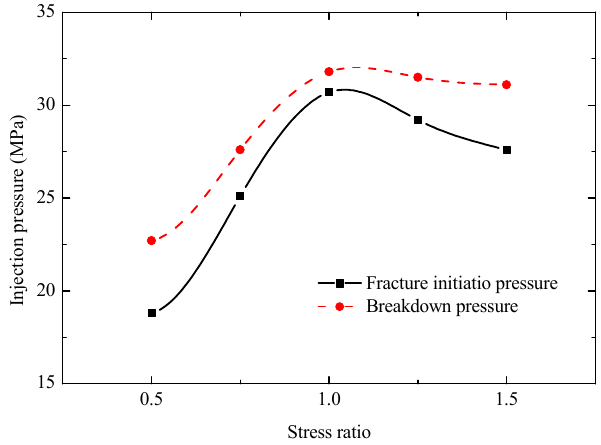
Figure 15. Changes of fracture initiation pressure and breakdown pressure with stress ratio.